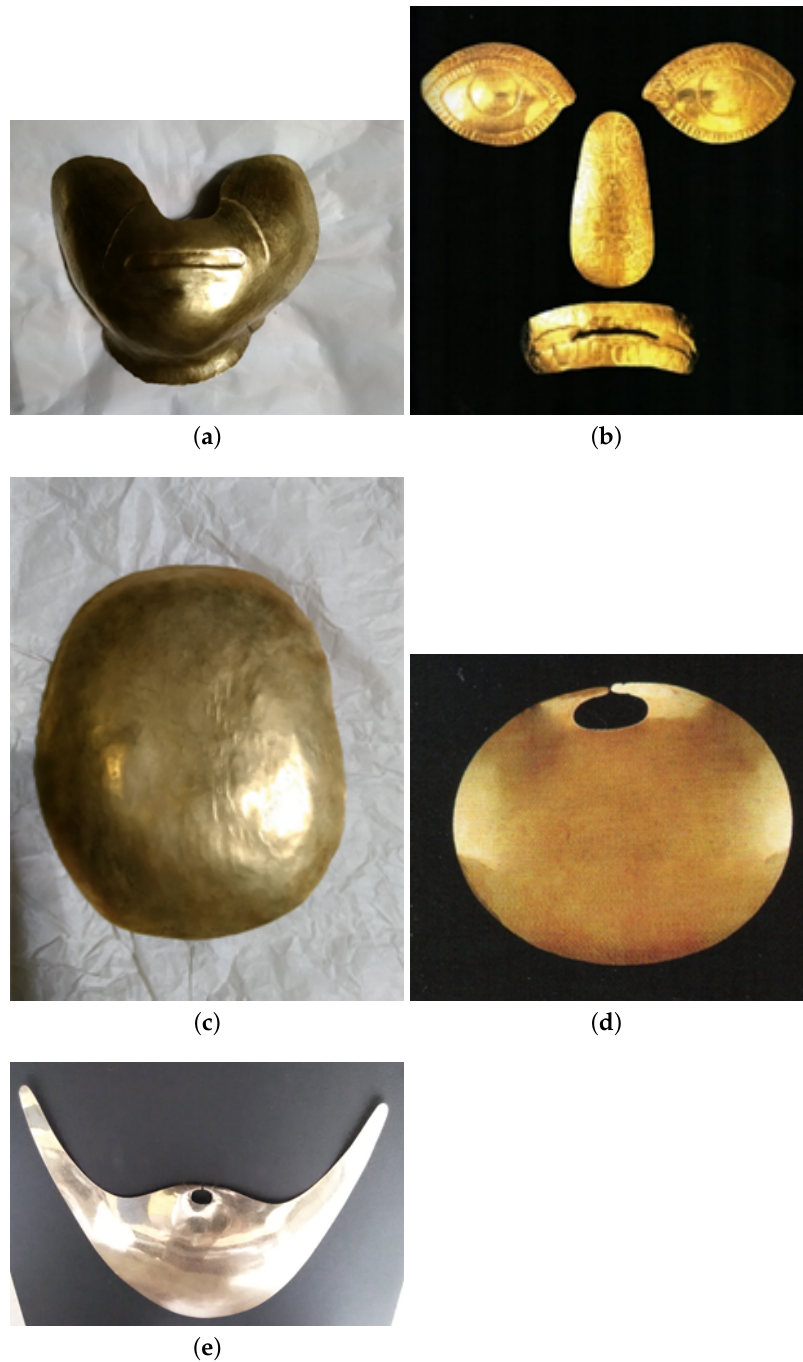
Figure 2. Pictures of most of the samples examined here and kept at Museum Royal Tombs of Sipan, (Lambayeque, Peru). ( a ) Chin protector; ( b ) Right and Left eye protector, Nose protection, Tooth protection; ( c ) Brain container; ( d ) Convex nose protector; ( e ) Nose